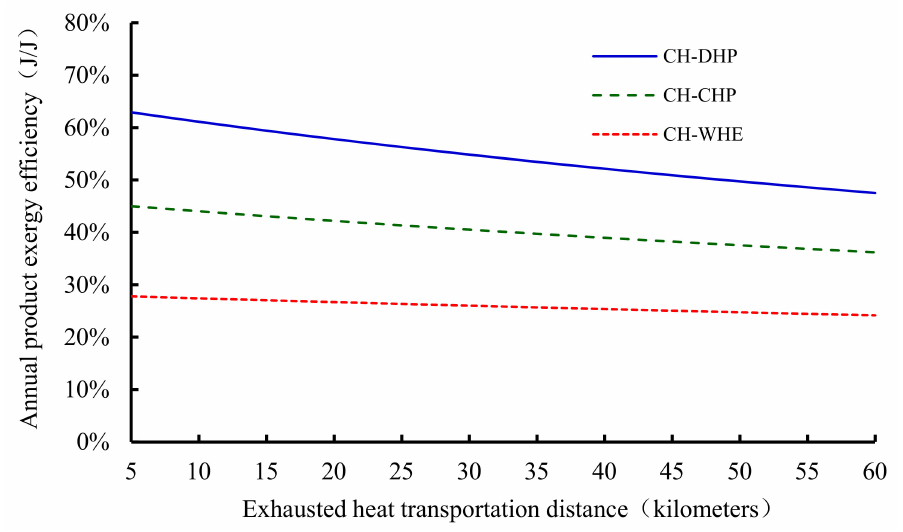
Figure 7. Impacts of exhausted heat transportation distance on annual product exergy efficiency ( APEE